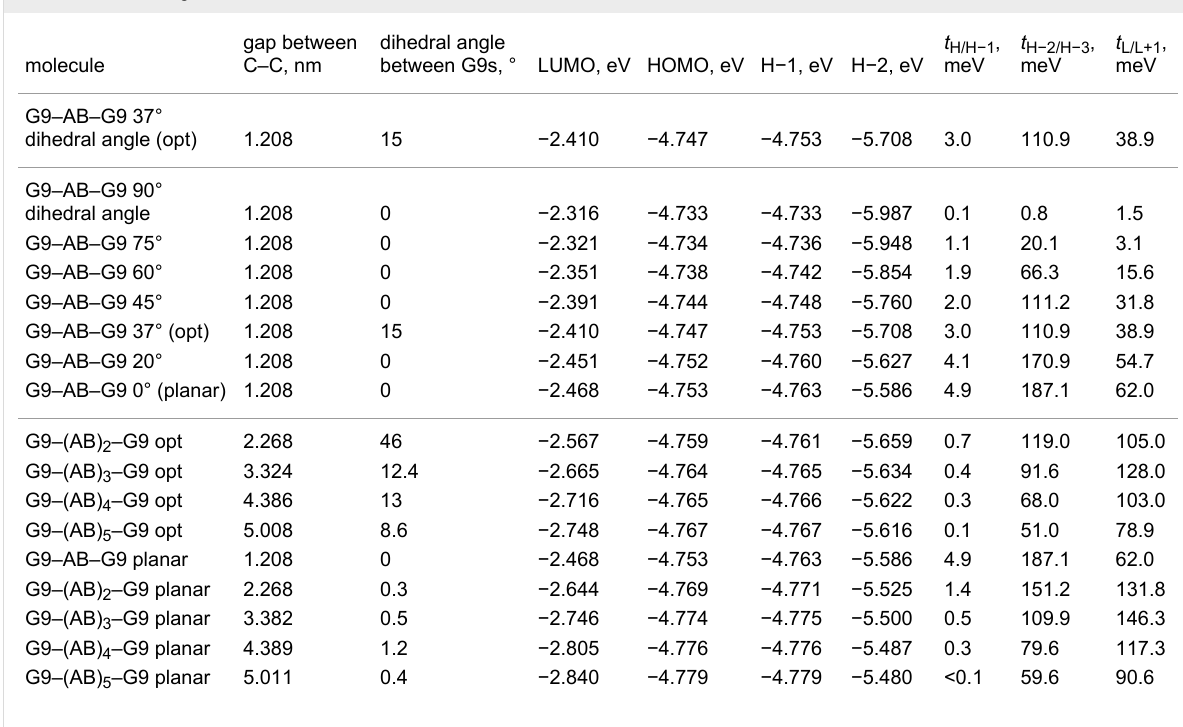
Table 3: Orbital energies for G9–AB–G9.